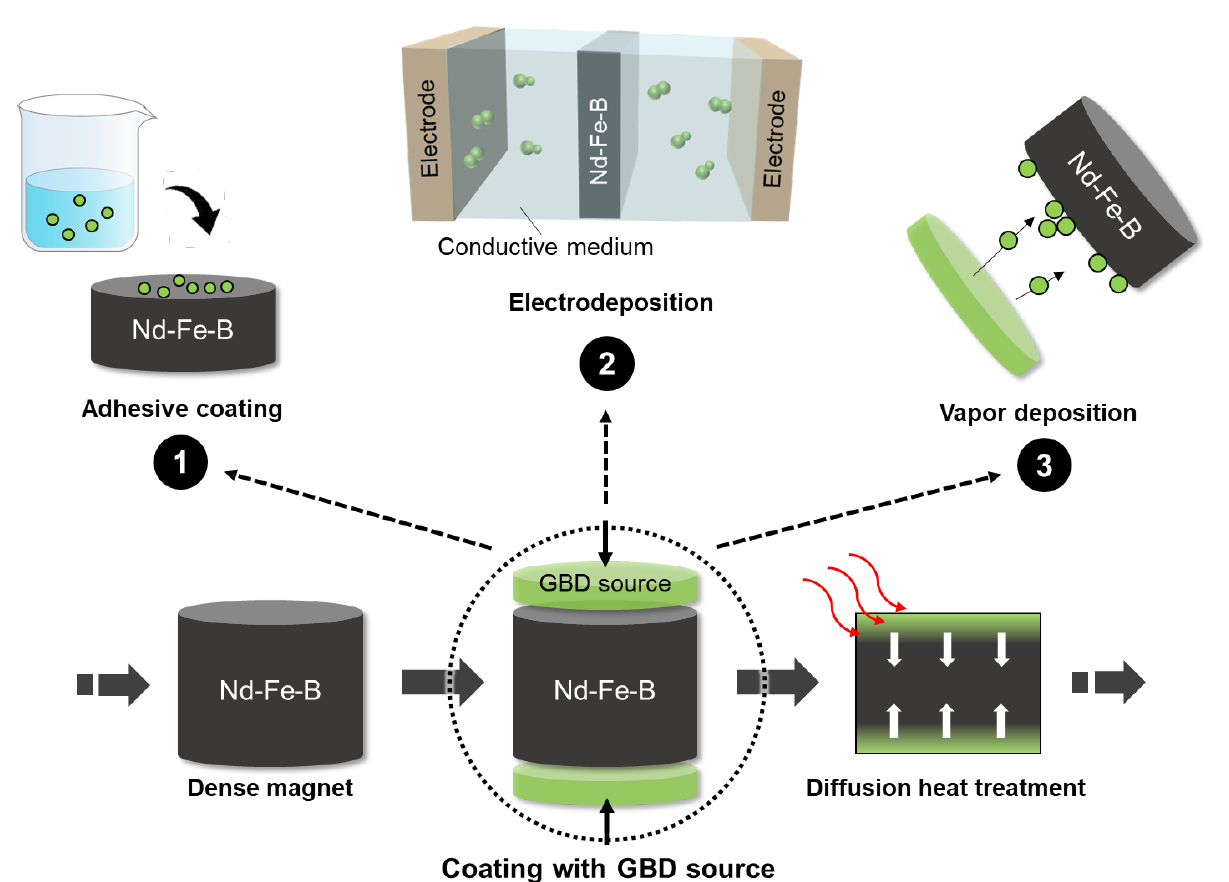
Figure 5. Processing steps of GBD and a classification of coating methods for GBD sources.